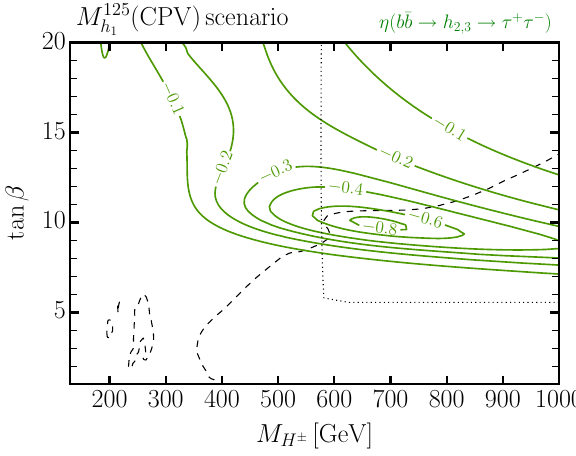
Fig. 13 ThesameexclusionboundariesasinFig.12aboveareoverlaid withcontoursoftherelativeinterferencefactor η( b ¯ b → h 2 , 3 → τ + τ − ) defined in